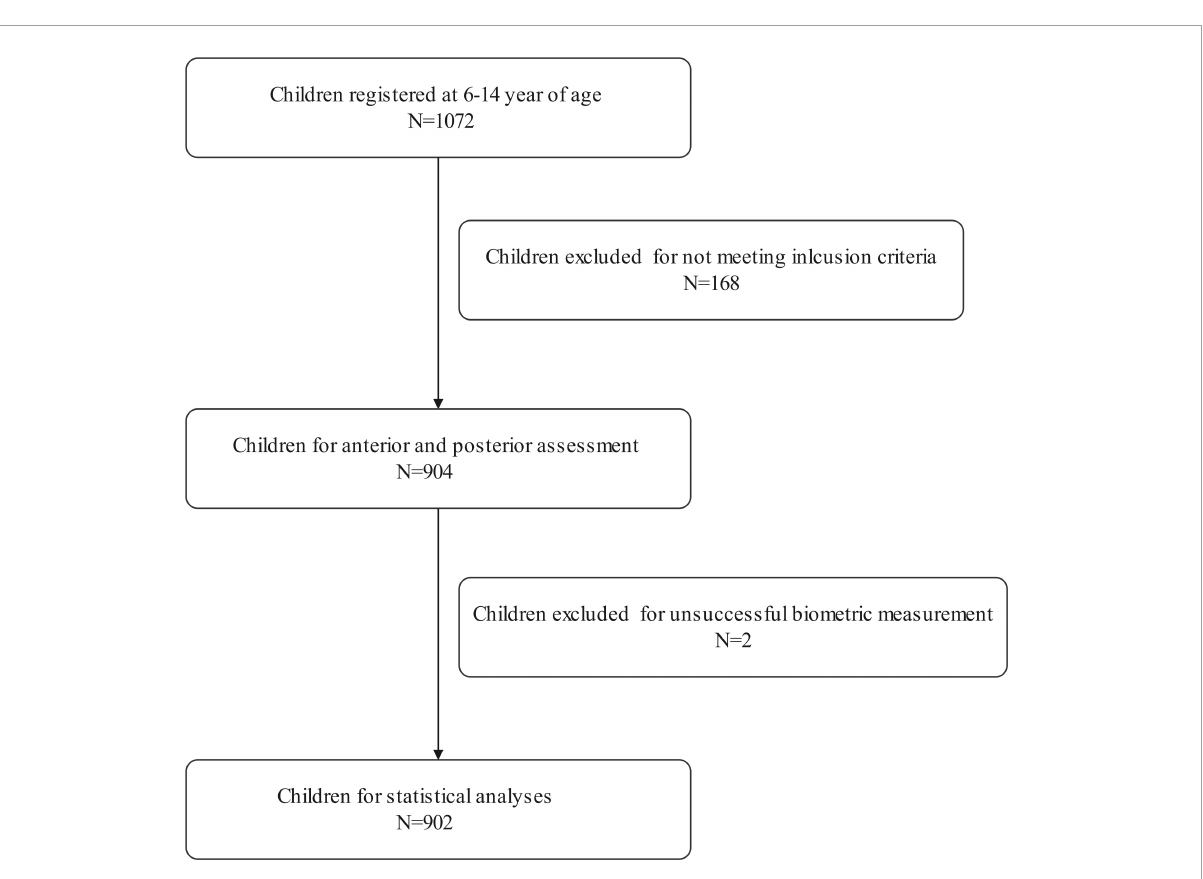
FIGURE1 A flowchart depicting the inclusion of participants assessed in this study.